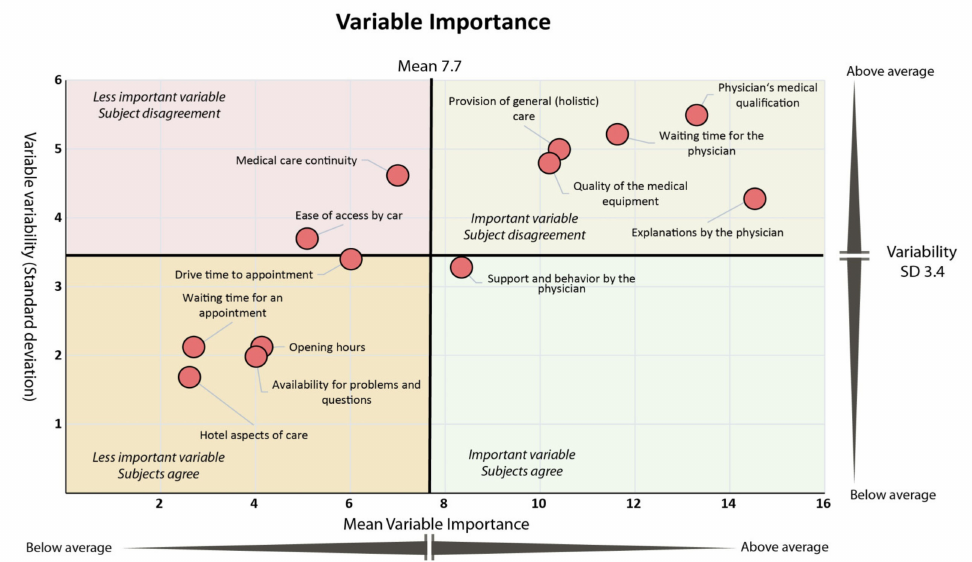
Figure 4. Scatterplot of variables’ average importance ( x -axis) versus their average variability measured as standard deviation (SD; y -axis). The figure shows which variables were not only rated as being of above or below average importance but also how well participants agreed on the importance assigned. For further discussion of the quadrants, see